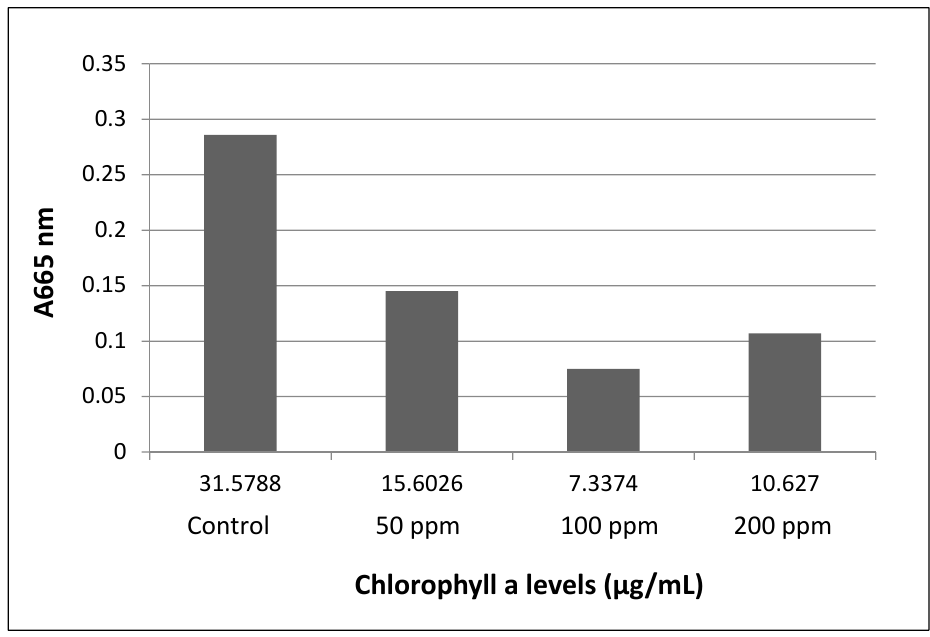
Figure 3. Chlorophyll a content at 665 nm absorption.